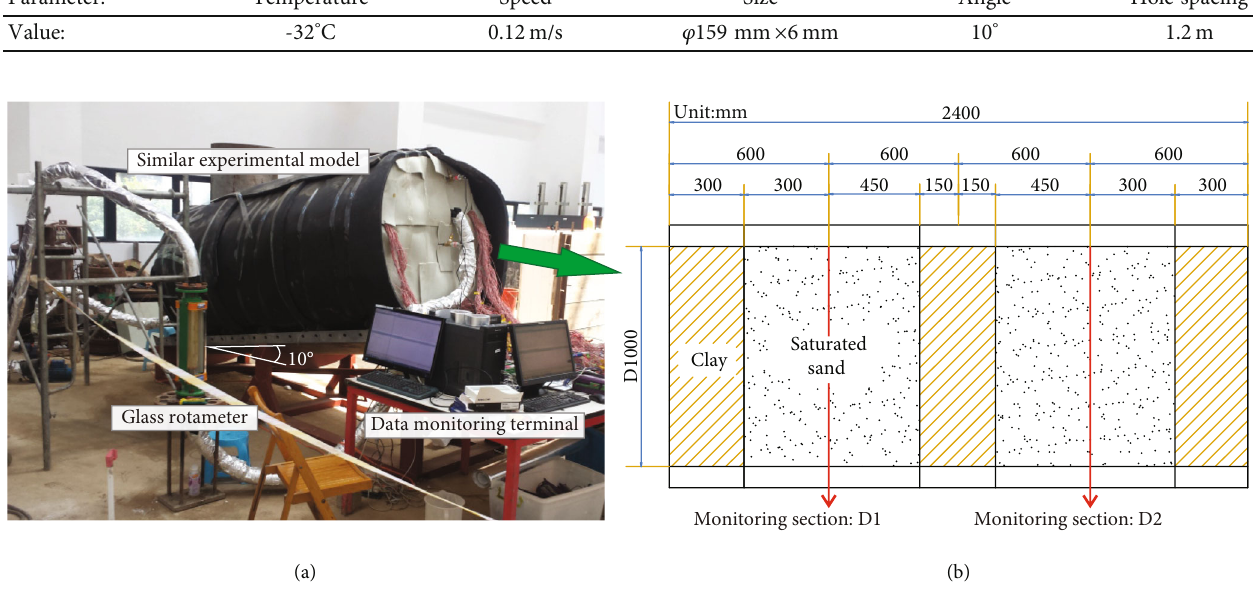
Figure 3: (a) Site photos of similar experiments and (b) parameters of stratum layout.